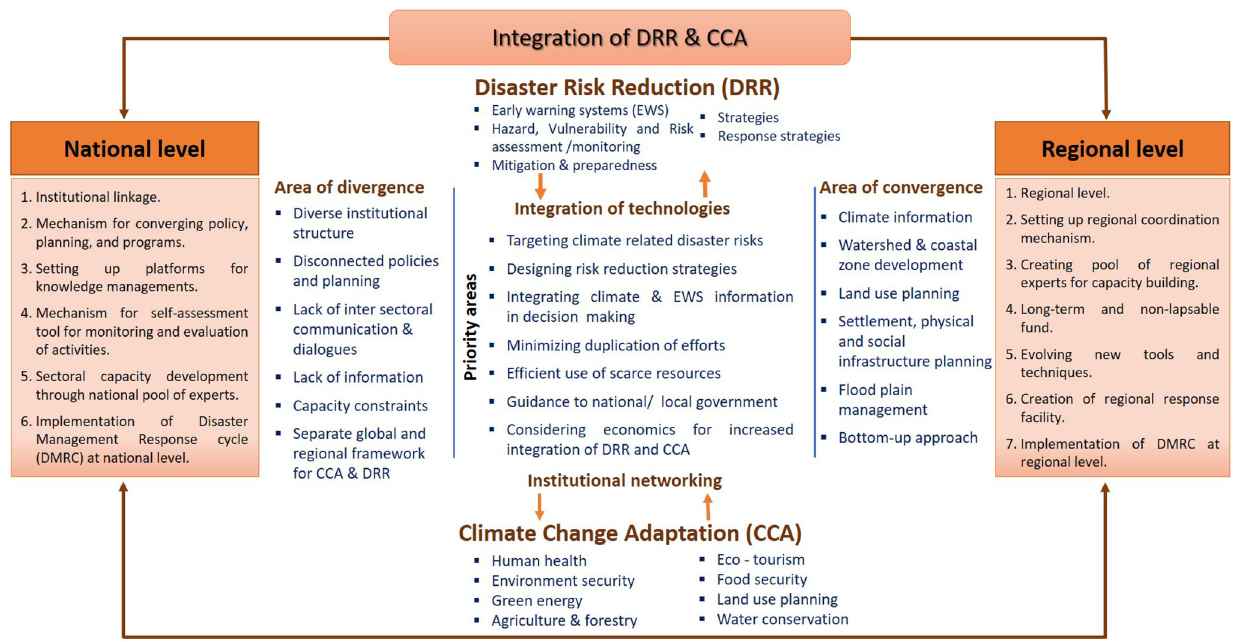
Fig. 2 Schematic diagram showing a holistic approach for integrating disaster risk reduction (DRR) with climate change adaptation (CCA) over the South Asian region. Source : Modified from Dhar